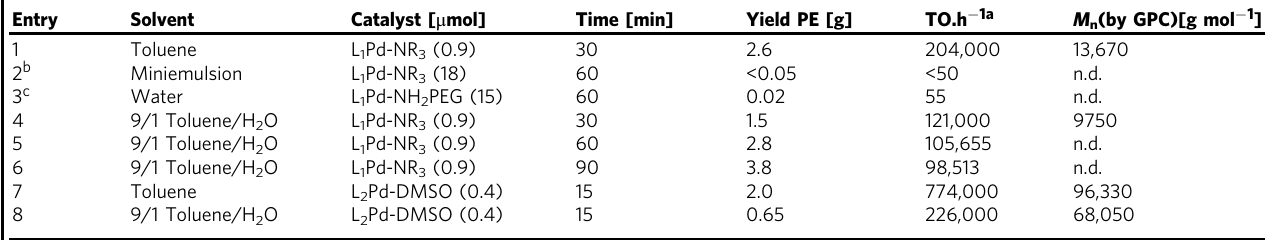
Table 1 Catalytic polymerizations of ethylene by palladium catalyst in different reaction media